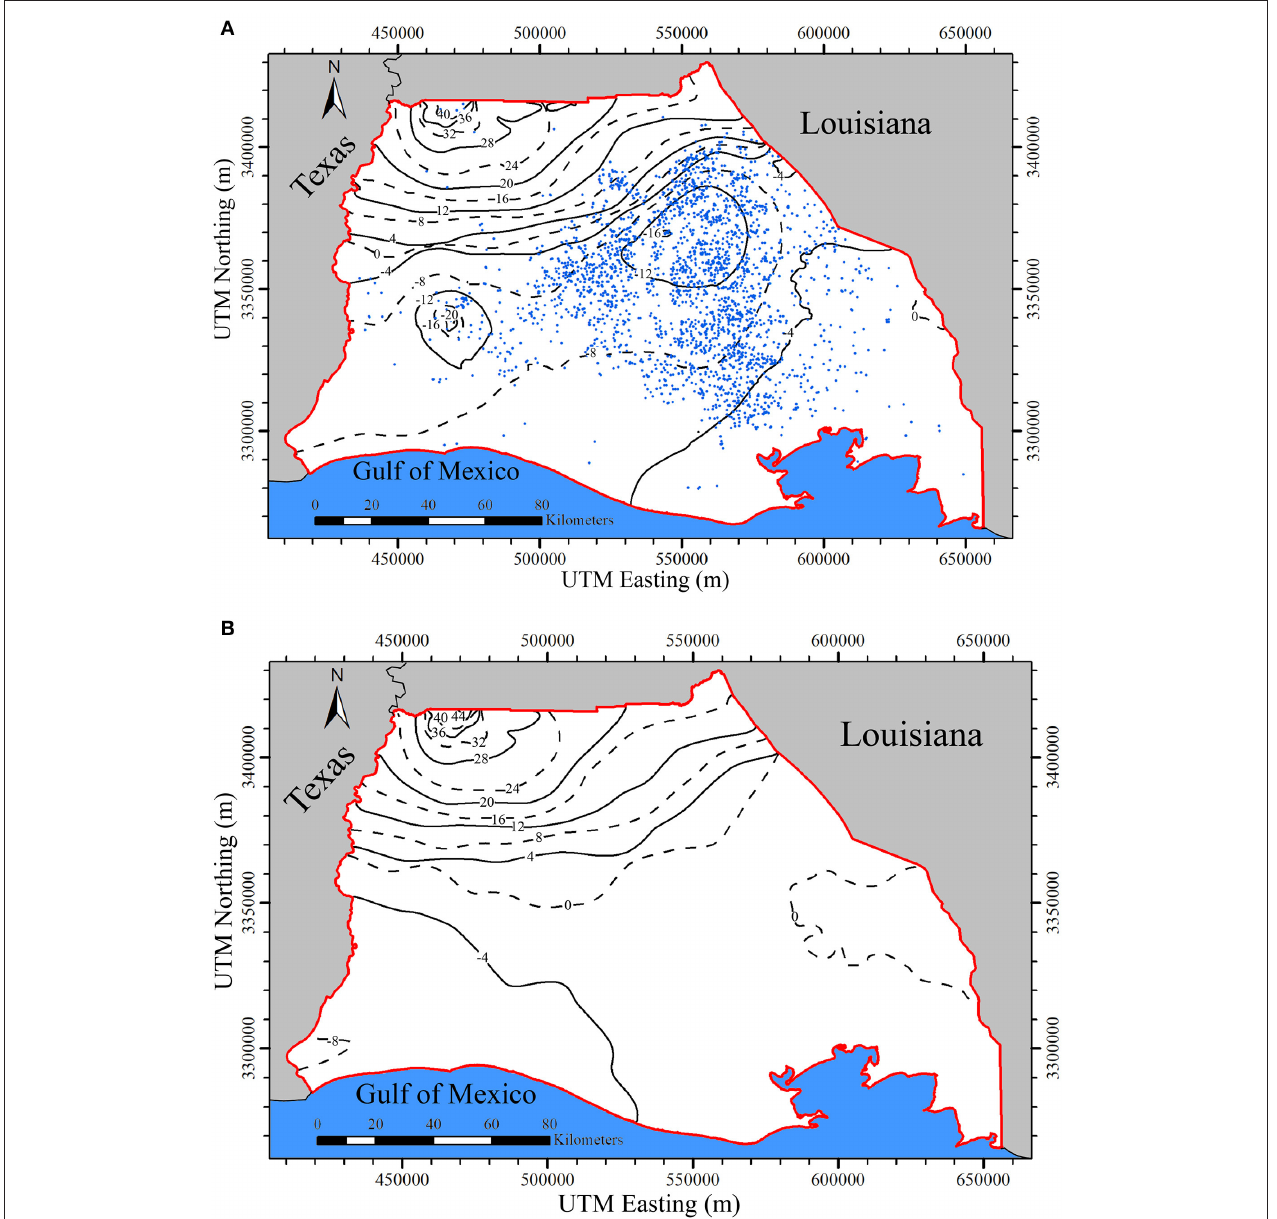
FIGURE 10 | Groundwater level map of December 31, 2014 for the Chicot aquifer domain: (A) with pumping, and (B) without pumping. The groundwater level datum is NAVD 88.